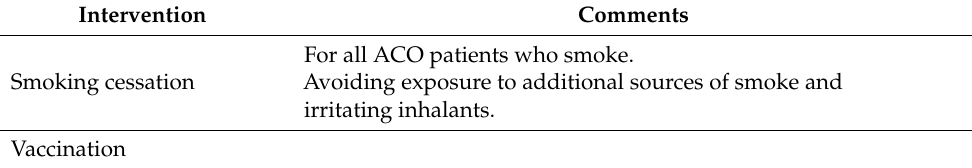
Table 4. The recommended non-pharmacological therapy for patients with ACO.